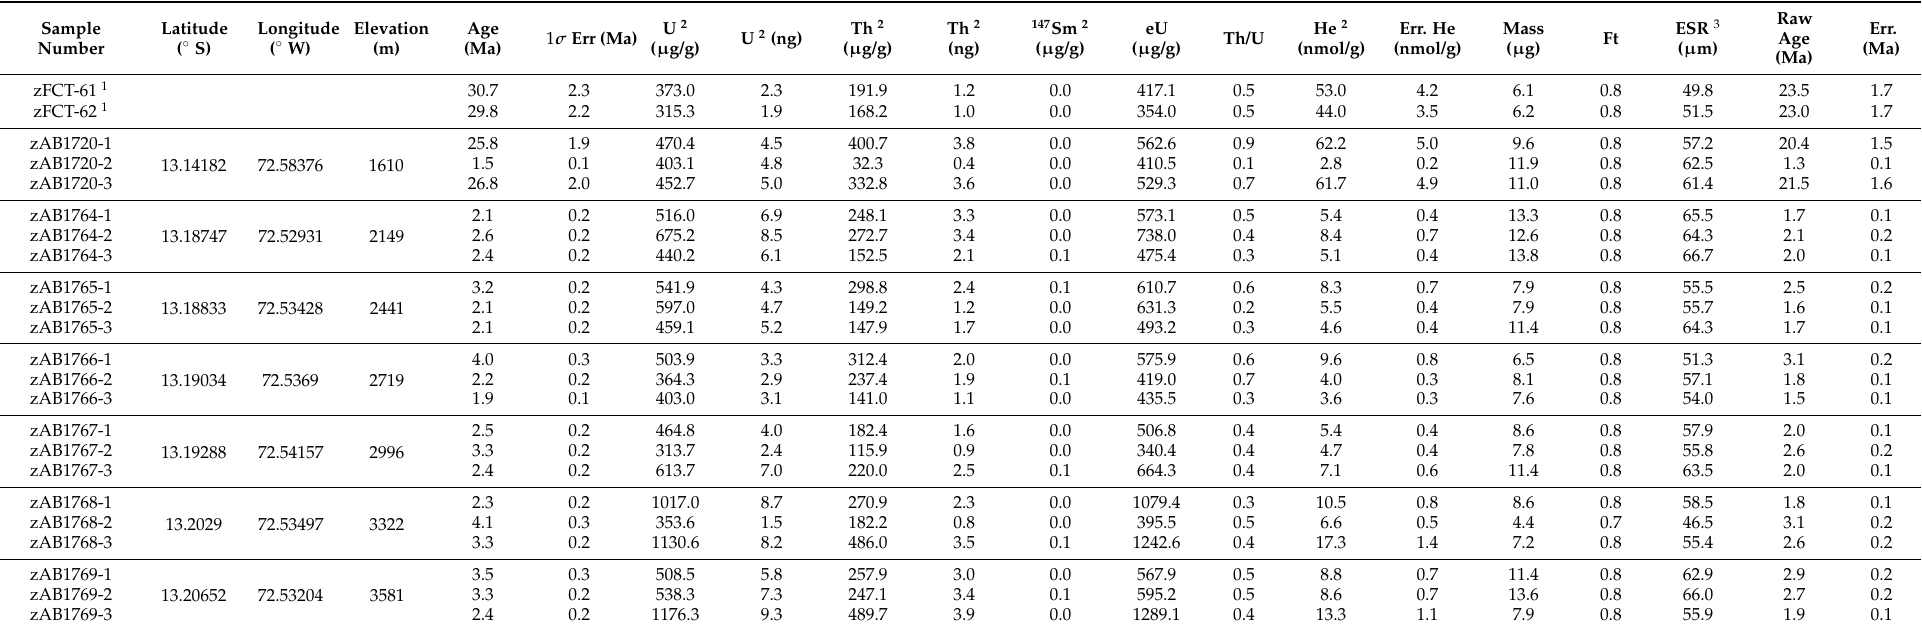
Table 1. Zircon (U-Th)/He